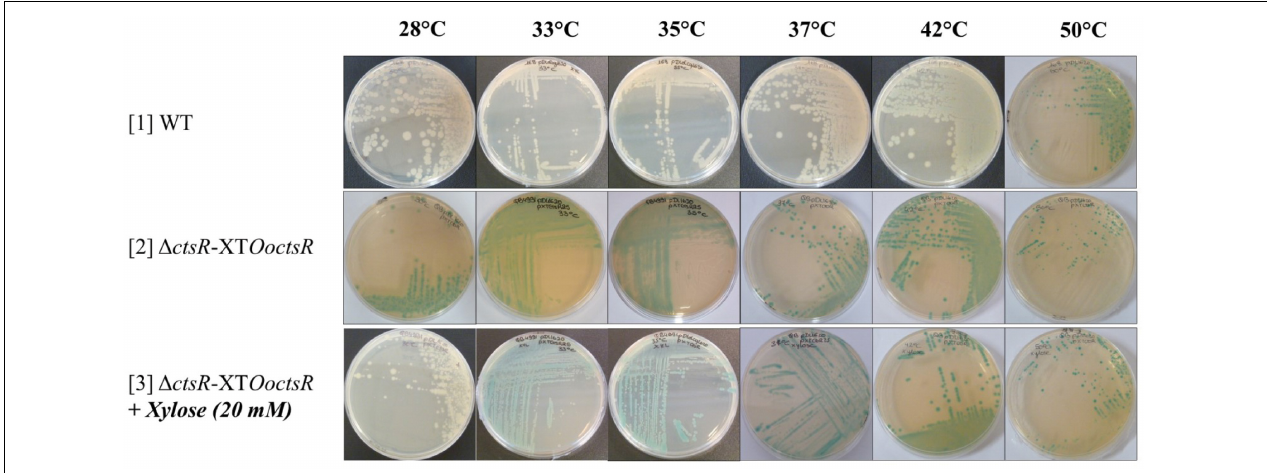
FIGURE 4 | The O. oeni CtsR repressor is a specific thermosensor in vivo . The O. oeni ctsR gene was expressed in the B. subtilis (cid:49) ctsR mutant strain ( (cid:49) ctsR- XT OoctsR ) under the control of a xylose-inducible promoter. Repression of hsp18’-bgaB expression by CtsR was monitored at different temperatures (28, 33, 35, 37, 42, and 50 ◦ C) by blue/white screening on X-Gal